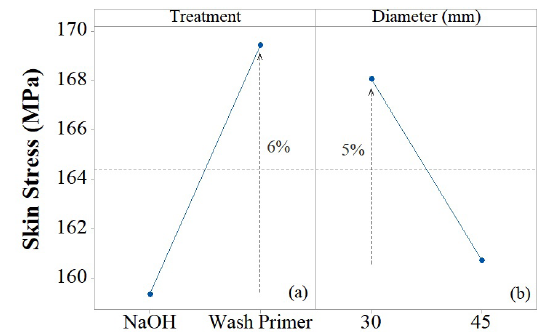
Figure 7. Main effect plots for the mean flexural strength.